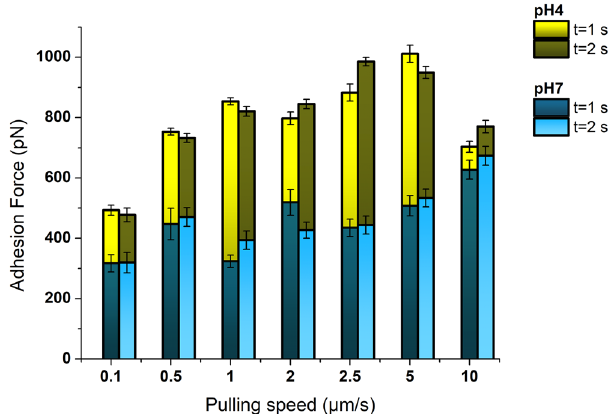
Figure 2. Adhesion force of mucin films as obtained from its contact with a hydrophilic tip for varying dwell times, and after exposure of the film to two different pH values: 4.0 – yellow- and 7.0 –blue-. Error bars indicate the mean error for N > 50